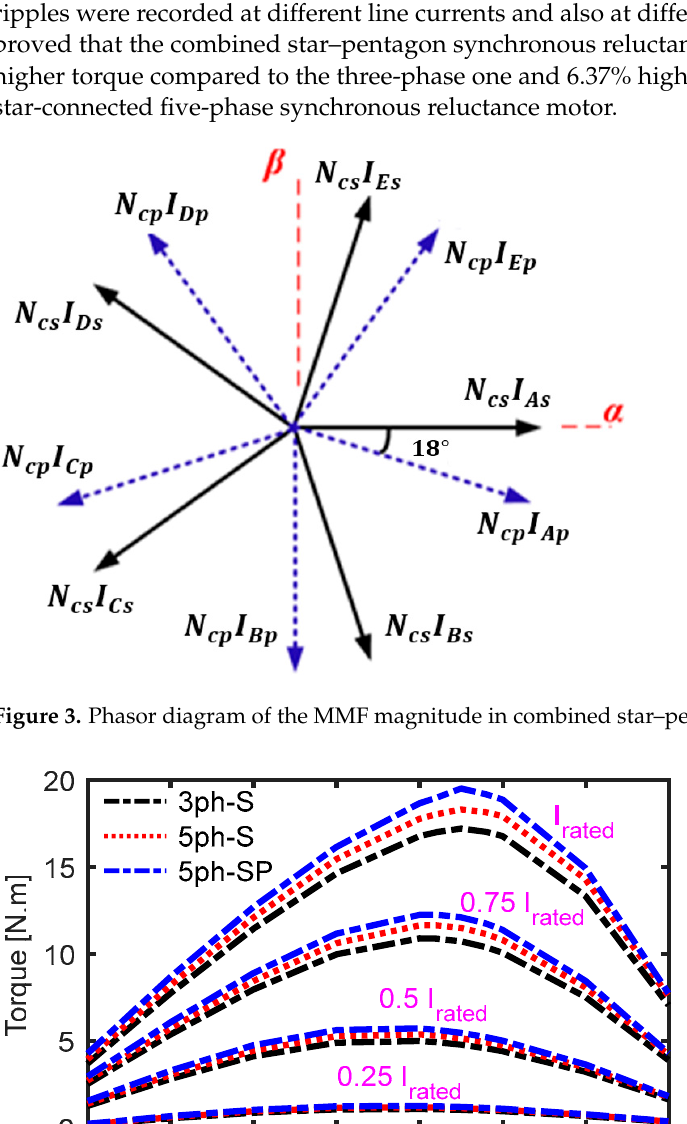
4 of 12 Figure 2. Combined star–pentagon connection.